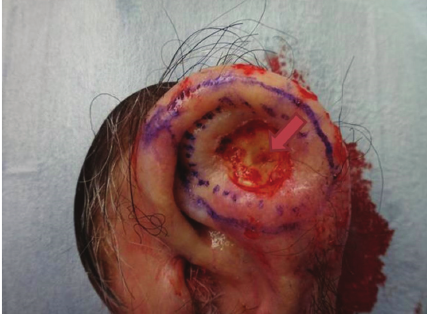
Figure 2: Left ear status after curettage of grossly positive tumor exposing perforation of scapha cartilage (arrow).